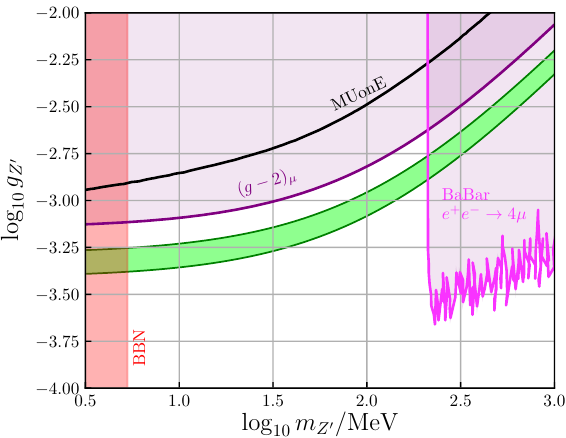
Figure 9 . MUonE sensitivity and current constraints on m red shaded region is the BBN limit on Z 0 mass and the color coding is the same as in (cid:12)gure 4. left and right panels of (cid:12)gure 8. Here we have rescaled the form factors by the factor of (cid:21) g 2 e= 16 (cid:25) 2 such that the contours in (cid:12)gure 8 do not depend on the gauge Z 0 (cid:17)